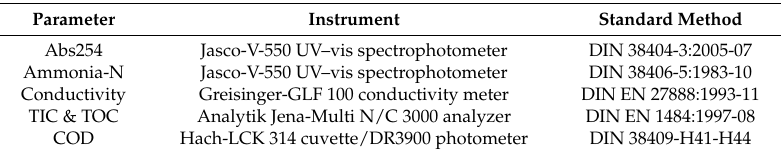
Table 4. Measured parameters and analytical procedures.